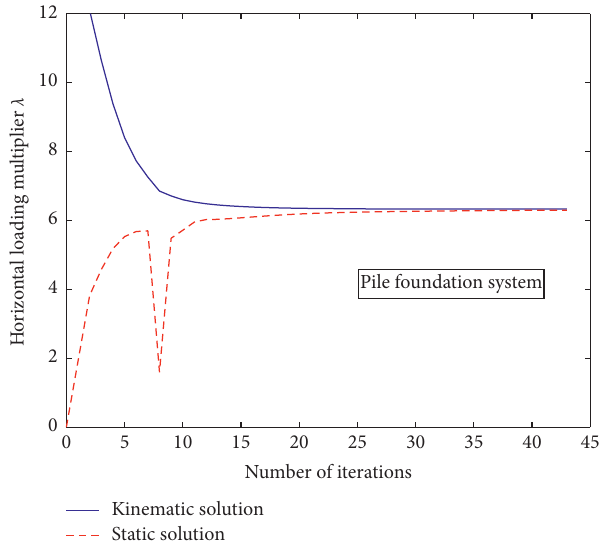
Figure 11: Variations of the kinematic and the static loading multipliers for the pile system.